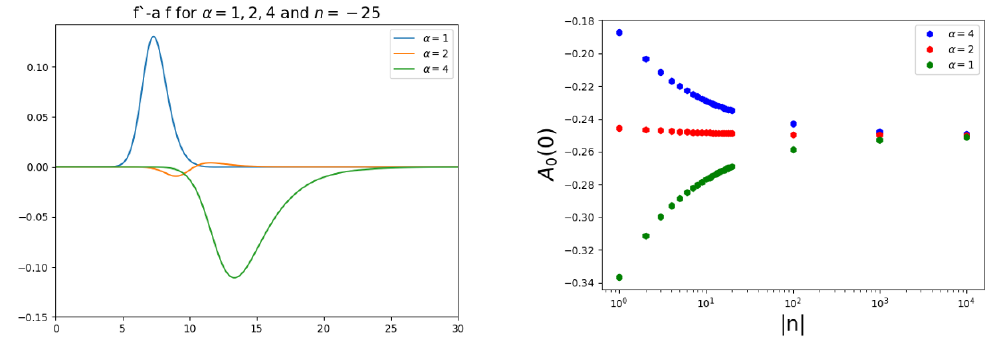
(cid:0) ~ (cid:1) Figure 7 . Left: f 0 (cid:0) a ~ f plotted for 3 values of (cid:11) including critical case. (cid:11) = 2. Right: the value of ~ A 0 at the origin for di(cid:11)erent (cid:11) as a function of j n j .